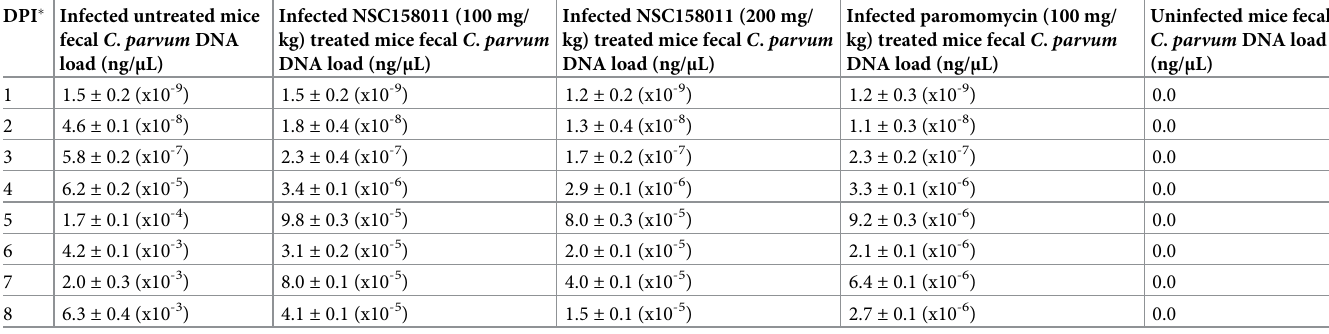
Table 5. Real-time PCR quantification of C . parvum DNA in fecal samples of treated or untreated infected mice. DPI � Infected untreated mice fecal C . parvum